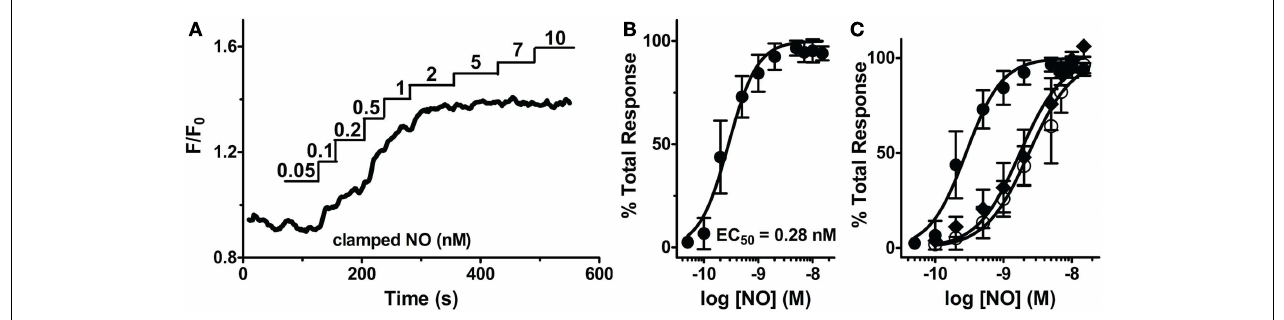
curves derived from traces ofVSM cells cultured for 4days (closed circles), 6days (open circles), and 4day cultured, Angiotensin II-treated cells (1 µ M, diamonds).